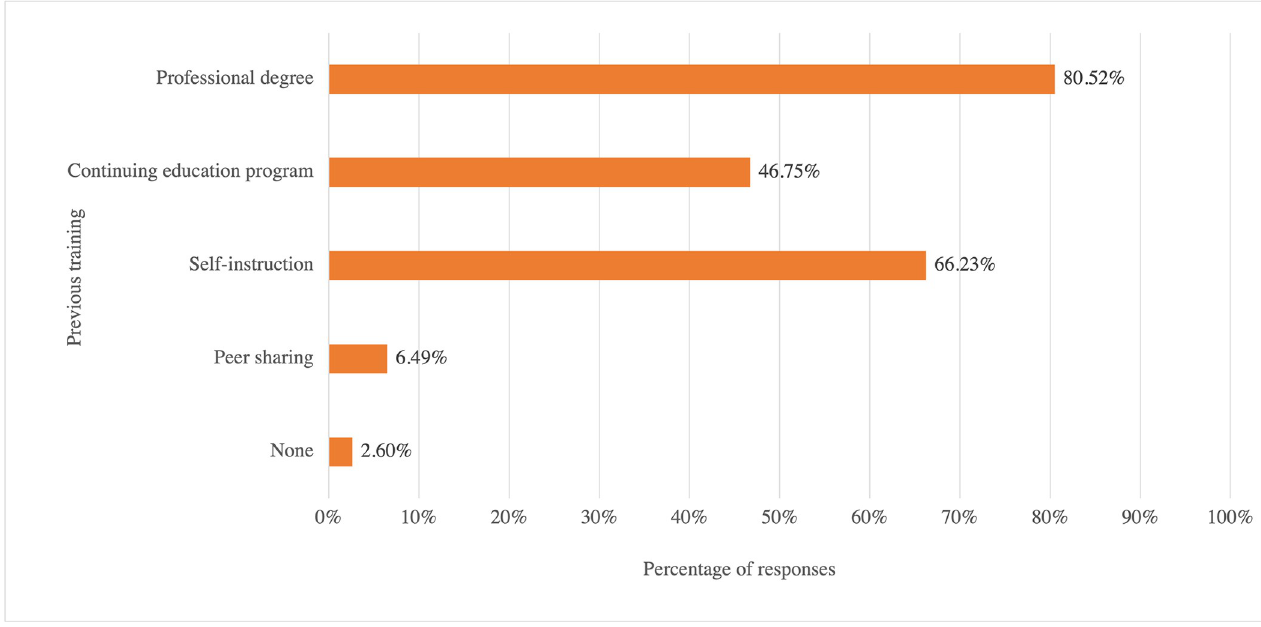
Fig 3. Respondents’ previous training in childhood apraxia of